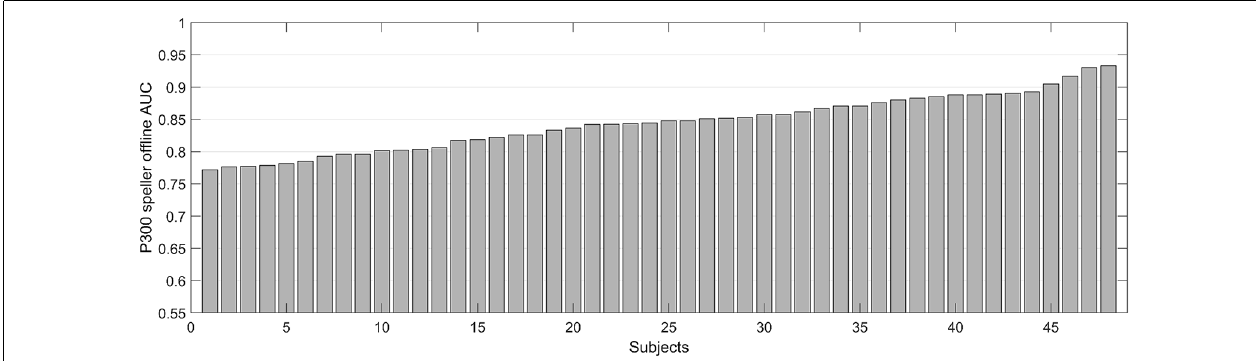
FIGURE 3 | P300 speller offline area under the ROC curve (AUC). This indicates sorted P300 speller offline performance (single-trial-based binary classification) that was estimated by 10-fold cross-validation.